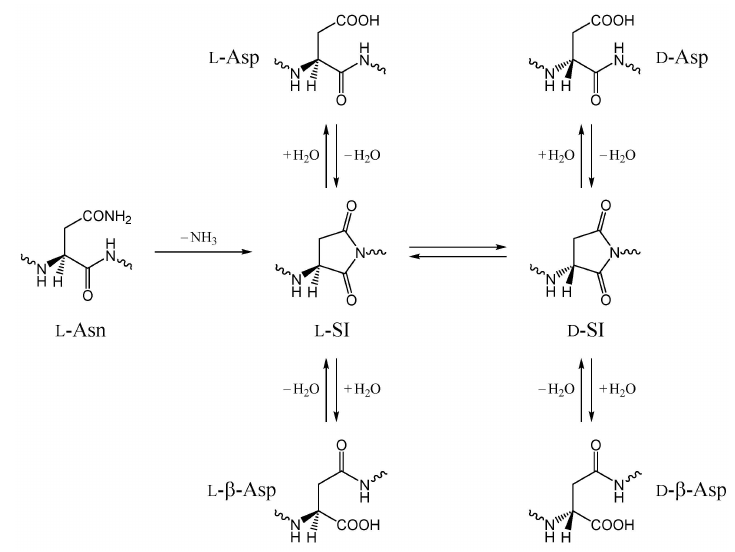
Scheme 1. Succinimide (SI)-mediated nonenzymatic reactions of Asn and Asp